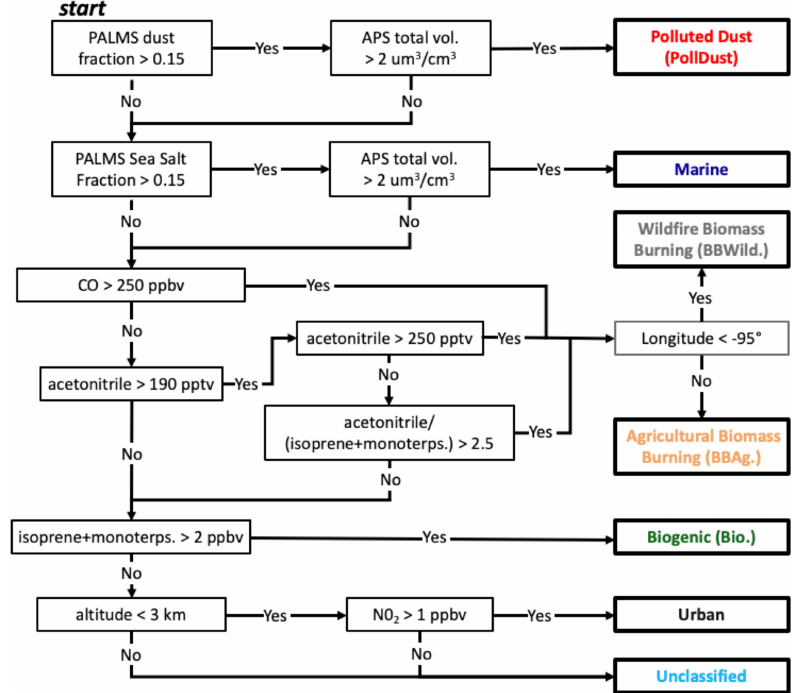
Figure 2. Scheme to pre-specify air mass types (PS-AMTs; step 1 of Fig. 1) using mostly gas measurements and a method based on Espinosa et al. (2018) and Shingler et al. (2016) but modified to include marine and two different types of BB AMTs (i.e., BBAg. and